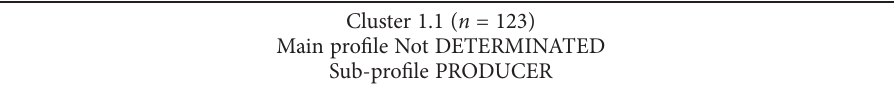
Table 12. Characterization of the clusters of the second level of post-crisis chained cluster (source: own elaboration based on COMTRADE